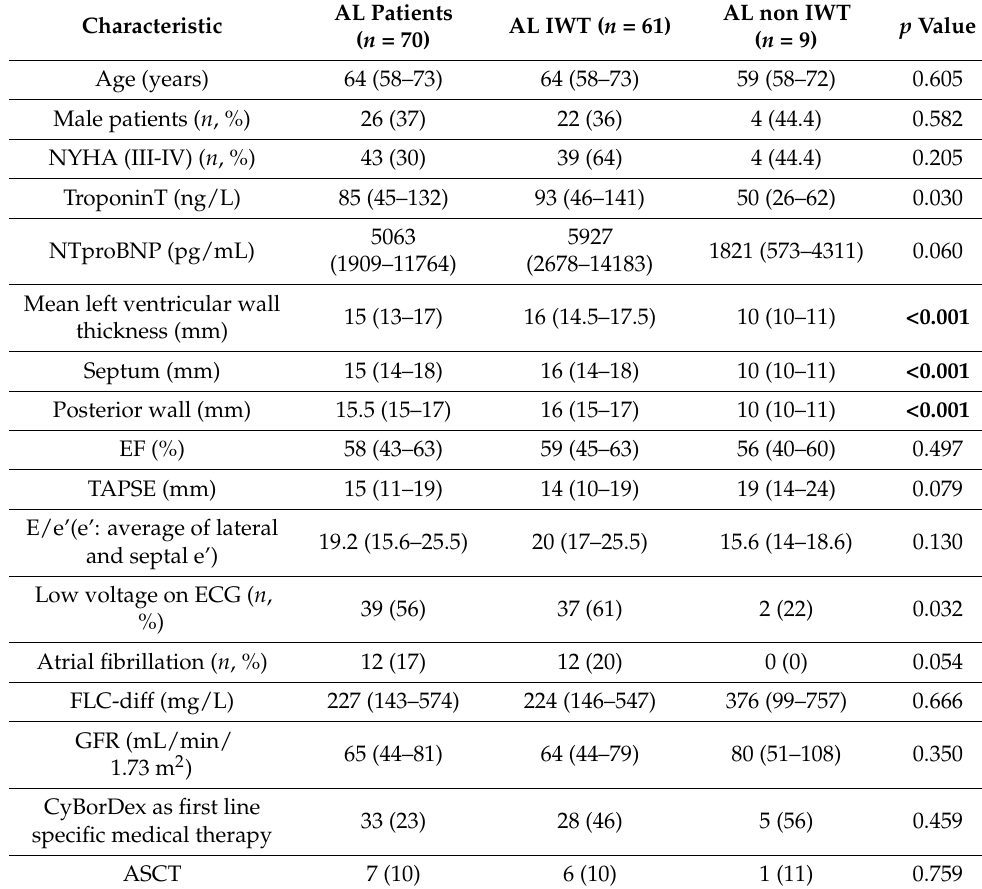
Table 3. Clinical characteristics, serum levels of cardiac biomarkers and other laboratory parameters, and the main echocardiographic and ECG parameters of the AL CA patients, grouped according to the presence or absence of increased wall